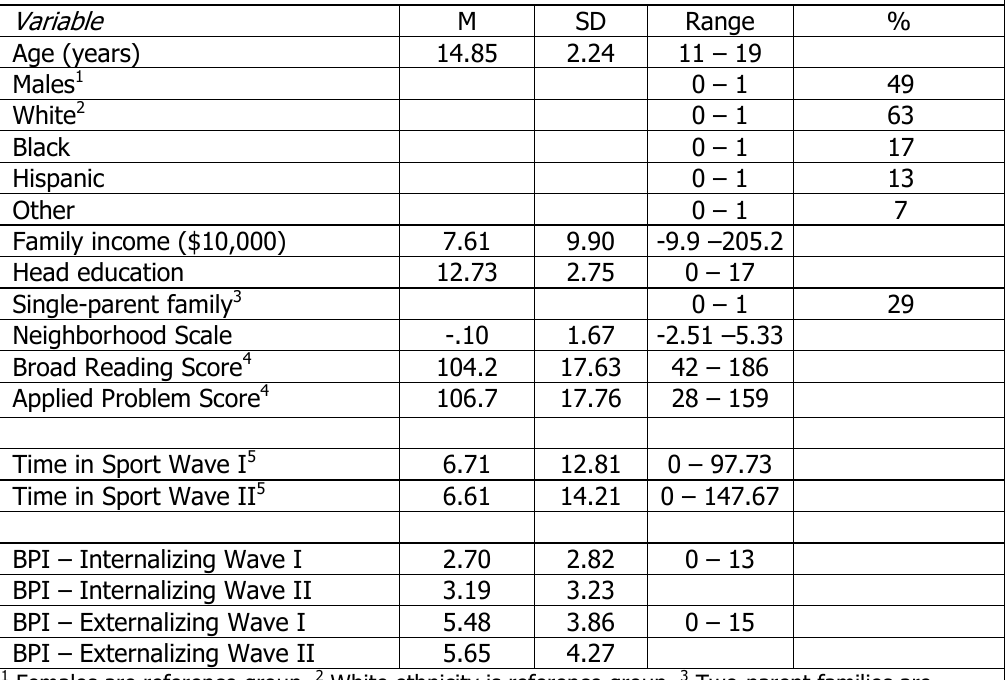
Means, Standard Deviations and Ranges for all Variables